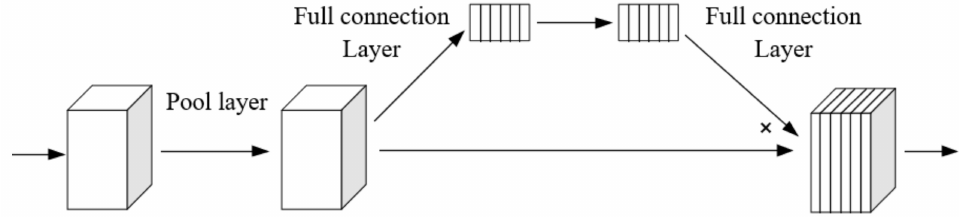
Figure 5. Implementation of the SENet attention mechanism.